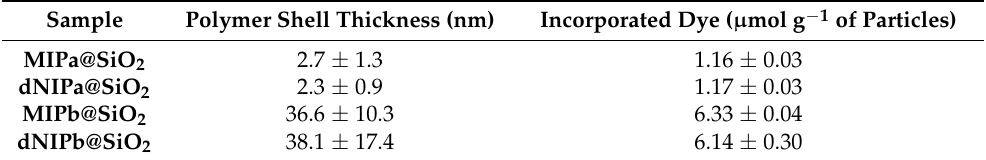
Table 2. Polymer shell thickness and amount of incorporated dye for the synthesized MIP and dNIP particles.